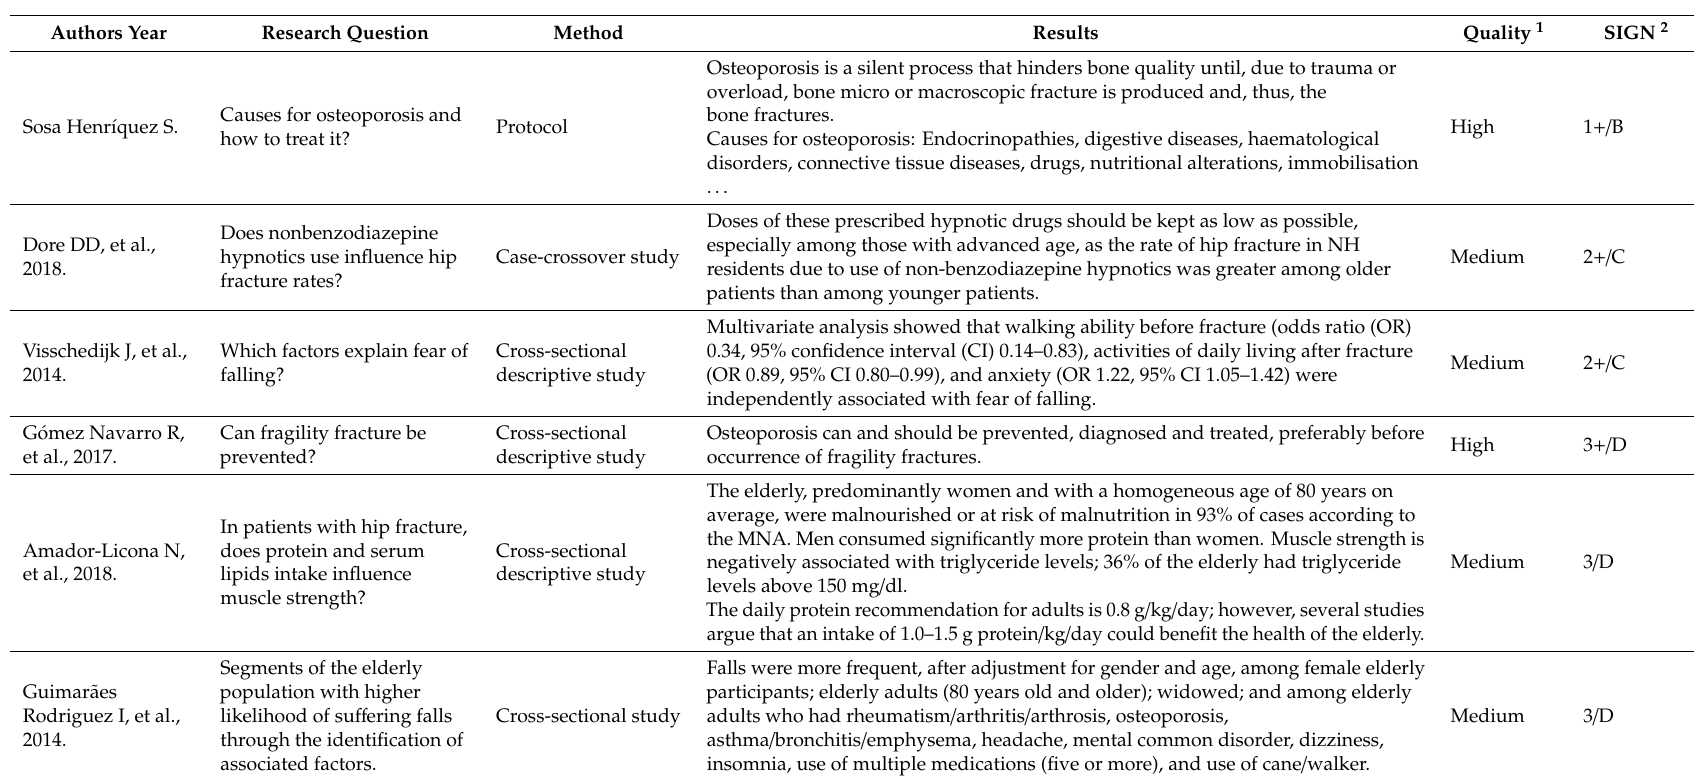
Table 4. Results from descriptive